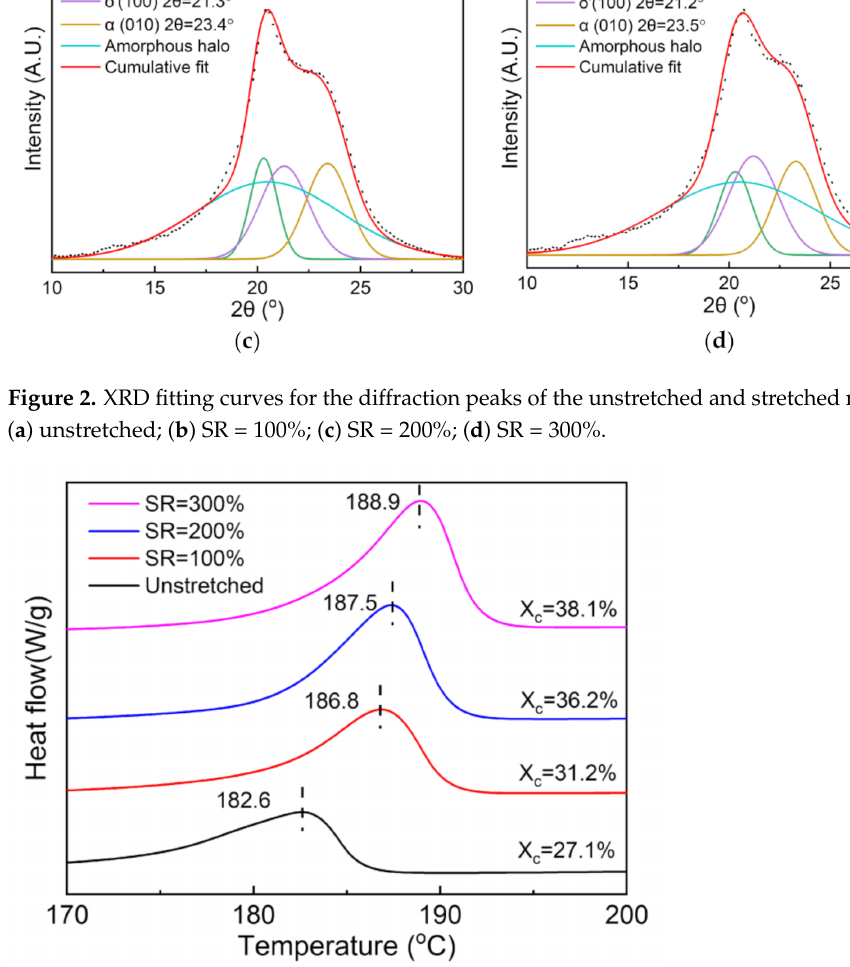
Figure 3. DSC melting curves of the nylon-11 films unstretched and stretched at 80 ◦ C with different stretching ratios